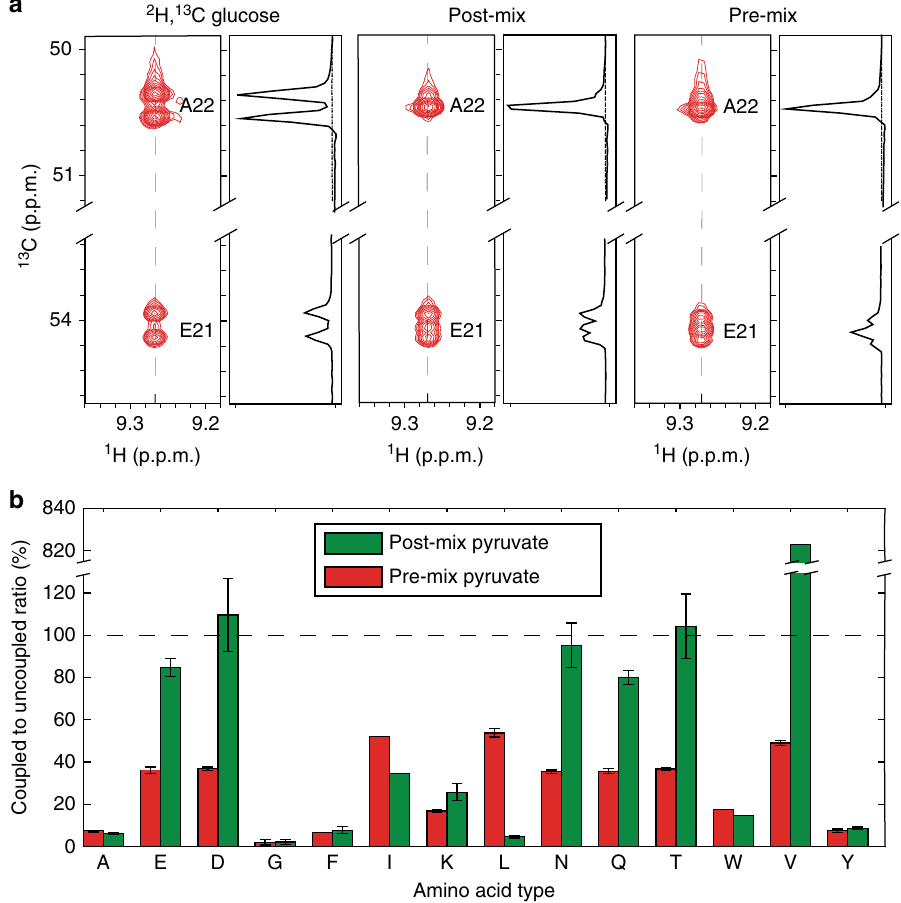
Fig. 2 Comparison of post-mix and pre-mix 2- 13 C and 3- 13 C pyruvate samples. a HNCA strips for spin system A22 of GB1. [U- 2 H 13 C] glucose labeling (left) is compared to post-mix (middle) and pre-mix samples (right). b Comparison of coupled to uncoupled peak height ratio (C2UR) for post-mix (green) and pre-mix (red). The dashed line indicates a height of 100%, when the heights of the coupled to uncoupled peaks are equal. Error bars indicate the standard deviation of the C2UR ratio for a given amino acid, based on all occurrences of the amino acid in the primary sequence. Absence of error bars indicates only one occurrence of that amino acid in the sequence of the carbon sources for protein expression. A graphical illustration